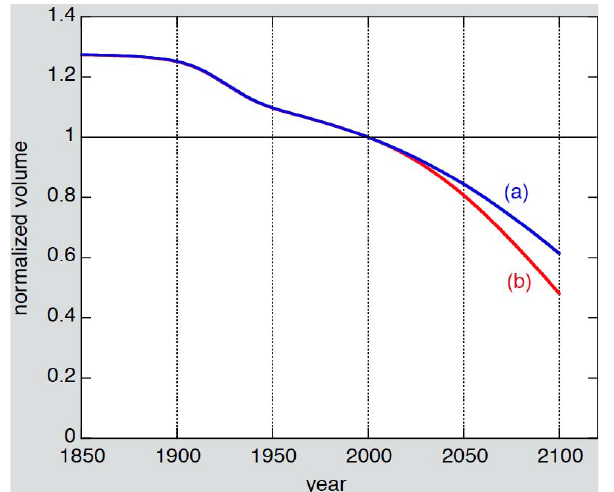
Fig. 7. Normalised ice volume for two different rates at which the equilibrium line rises from AD 2000 onwards: (a) : 0.72ma − 1 ; (b) : 2.16ma − 1 .